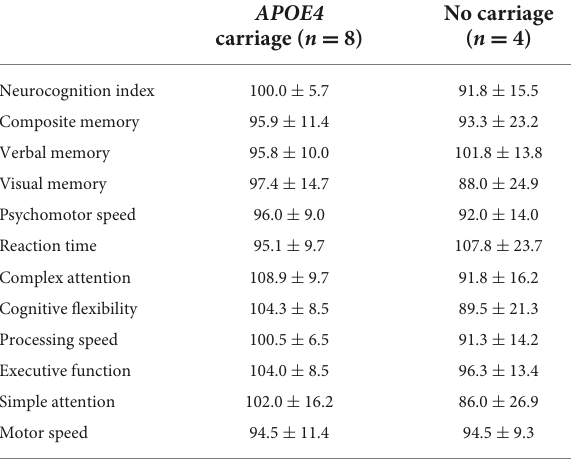
TABLE 3 Mean ± SD of each standardized cognitive domain score derived from the CNS Vital Signs evaluation dichotomized by apolipoprotein ε 4 ( APOE4 ) carriage